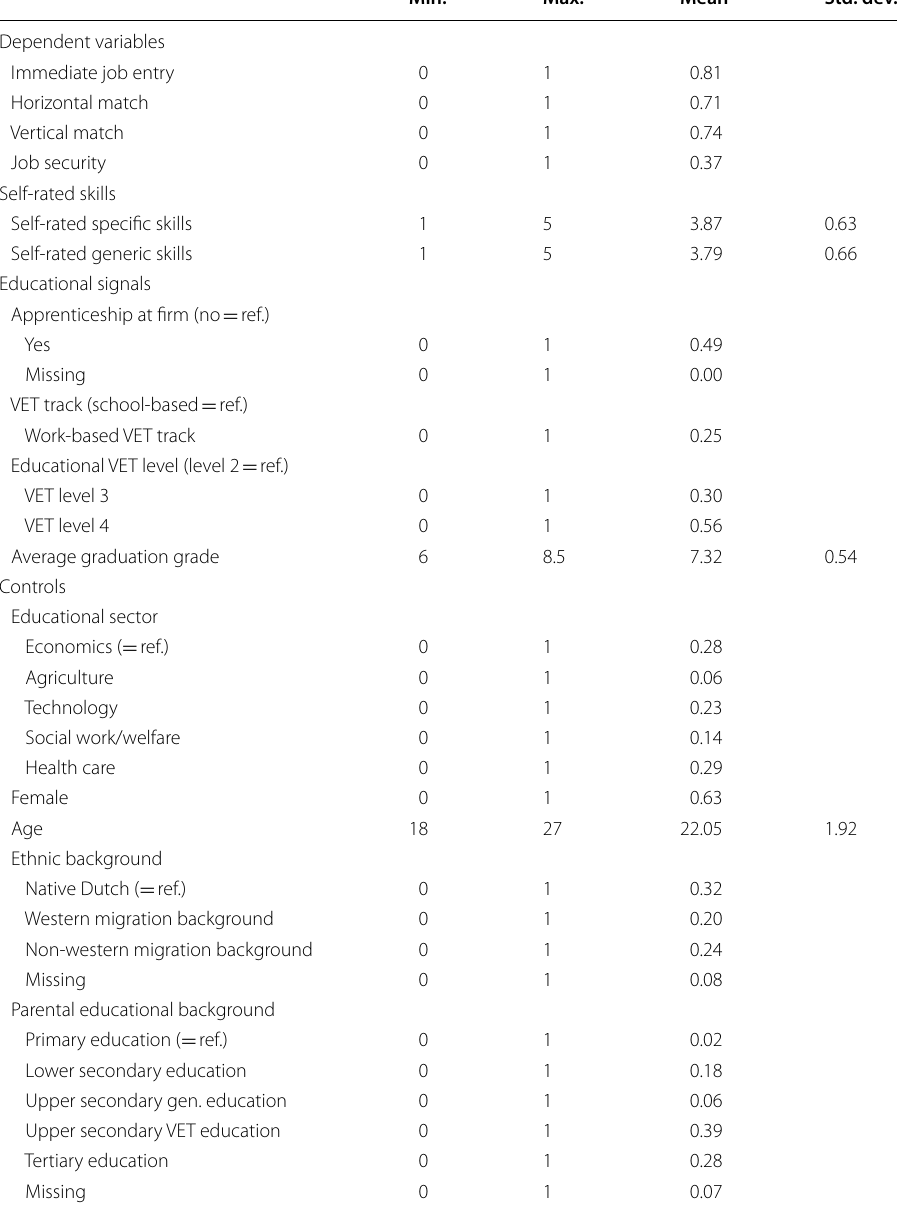
6014). Source: VET survey 2015 collected = Min. Max. Mean Std.